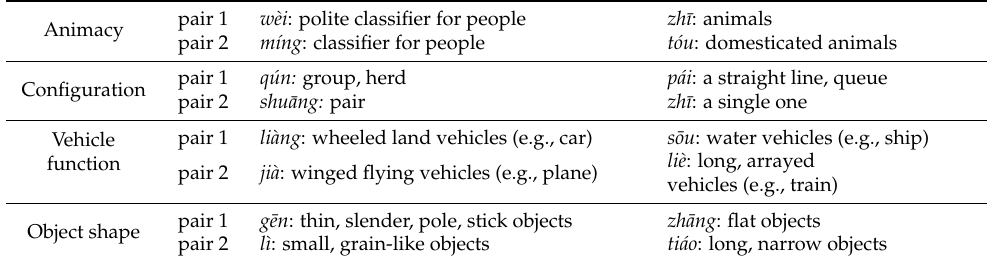
Table 1. The classifiers tested in this